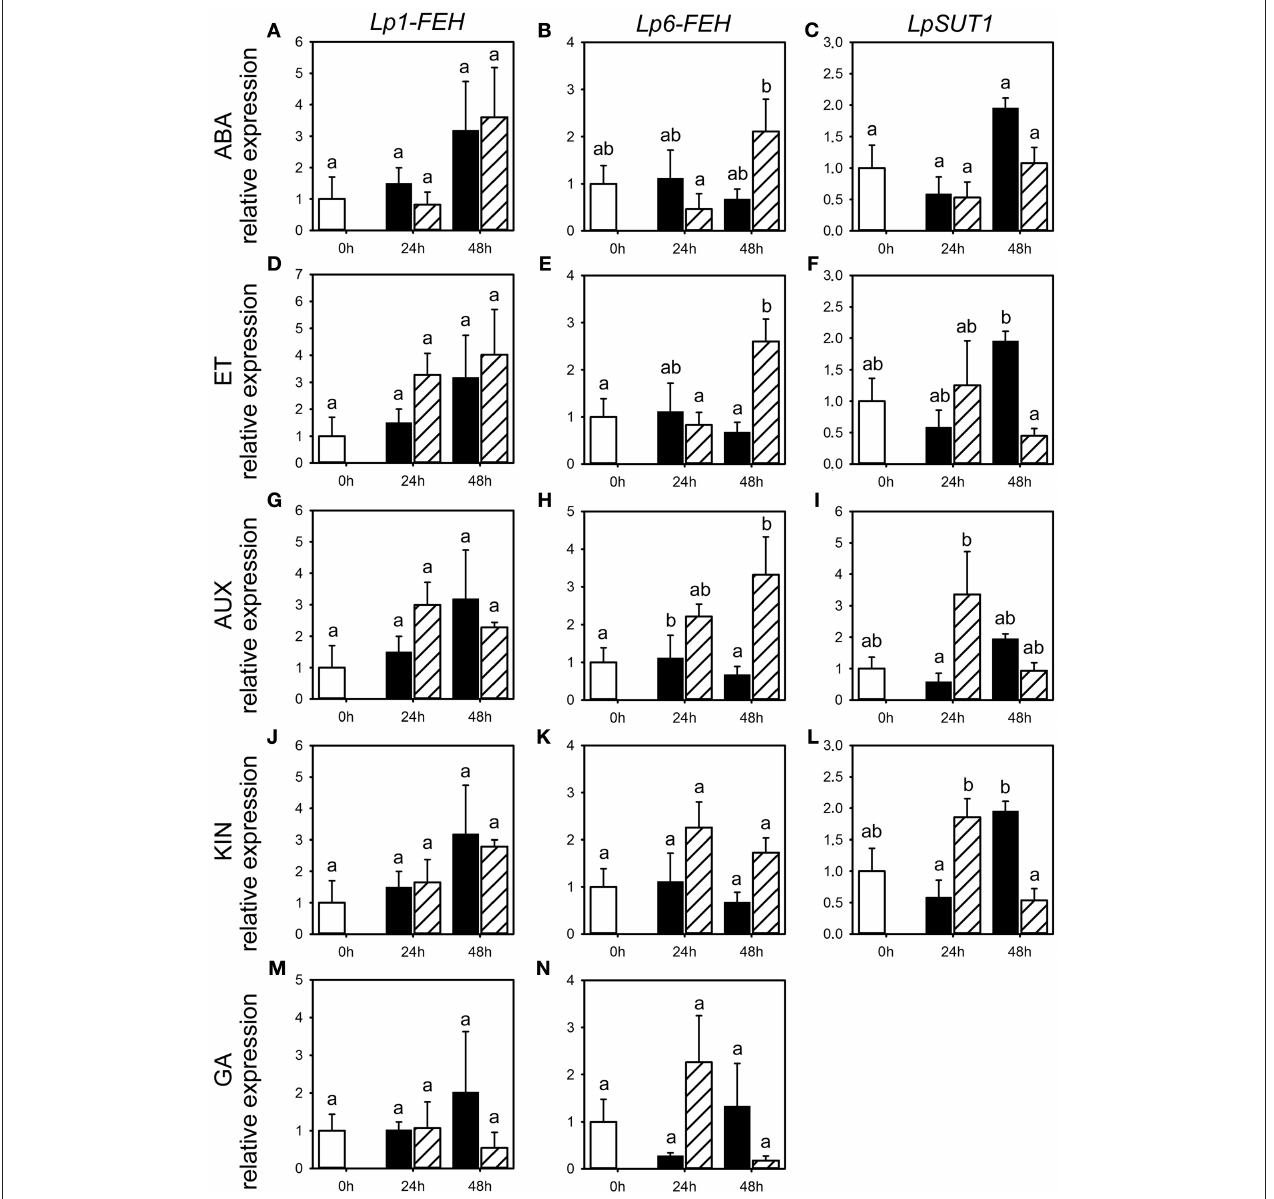
FIGURE 6 | Expression of FEHs and the SUT1 sucrose transporter following phytohormone treatments. Quantitative RT-PCR analysis of Lp1-FEH, Lp6-FEH, and LpSUT1 expression in stubble of 4-week old perennial ryegrass seedlings 24 or 48h post ABA (A–C) , ET (D–F) , AUX (G–I) , KIN (J–L), or GA (M,N) treatment. Open bars, untreated controls; closed bars, mock treatment; dashed bars, phytohormone treatment. Transcript levels were normalized to untreated controls (expression at 0h). Values represent the mean of three biological replicates ± SE. Different letters indicate statistical significance at p < 0.05